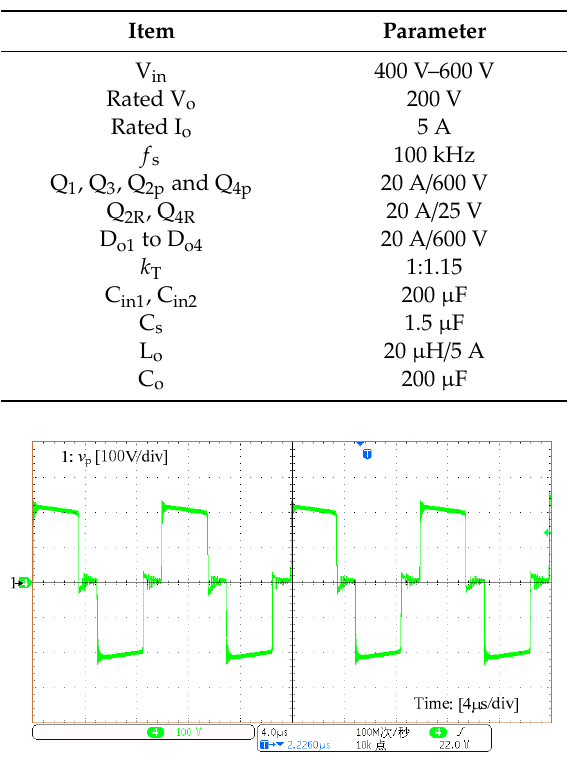
Table 4. Specifications of the experimental equipment.